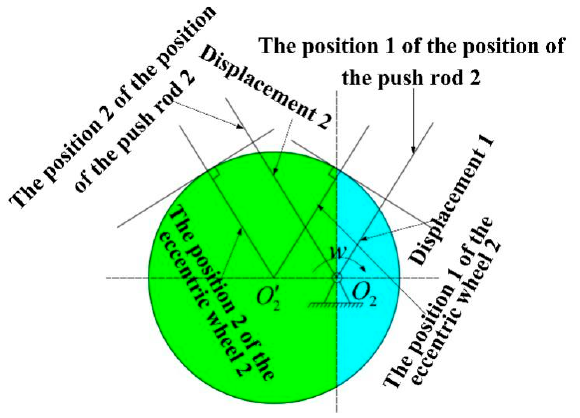
Figure 6. Push cam mechanism two.